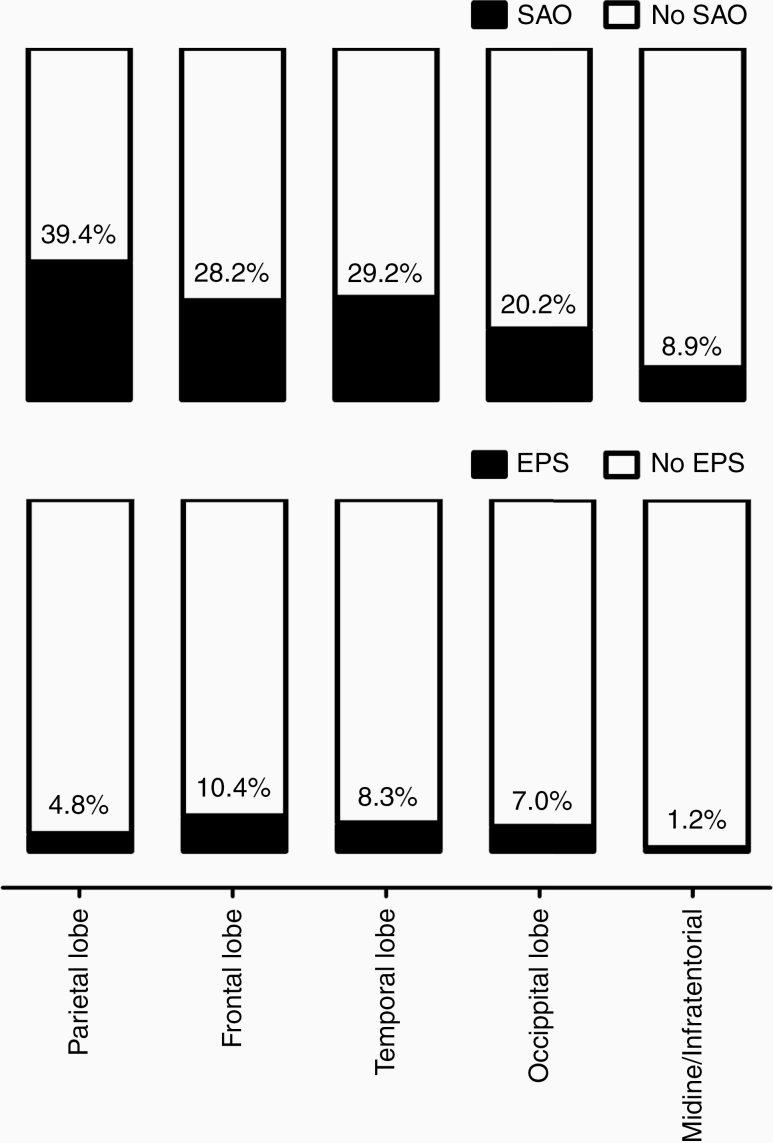
Incidence of SAO and EPS depending on tumor location